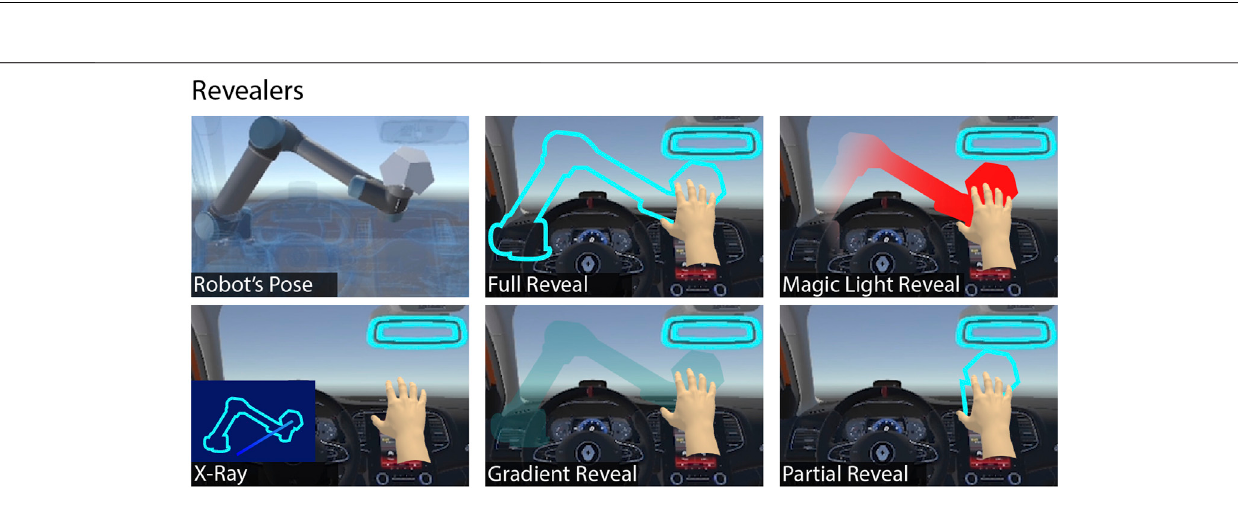
Frontiers in Virtual Reality |